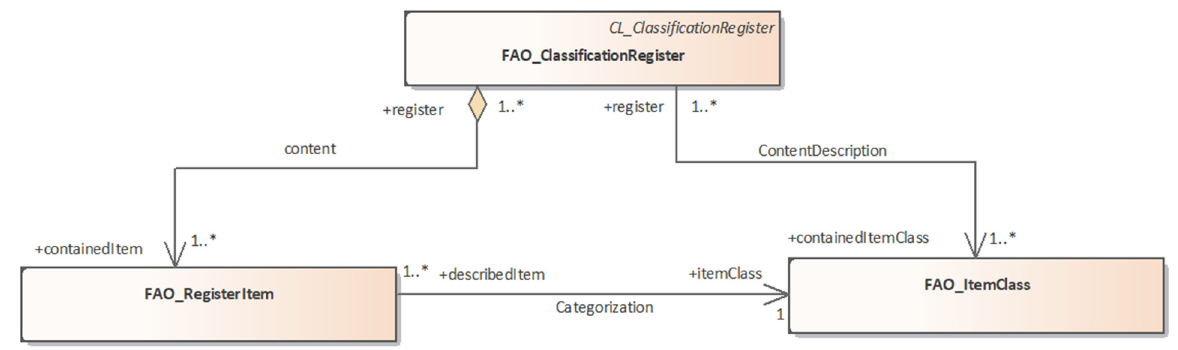
Figure 2. Structure of the land cover legend registry. Reprinted/adapted with permission from Ref. [28]. 2021, FAO, UoS and STIIMA-CNR. * Multiplicity (https://khalilstemmler.com/articles/uml-cheatsheet/, accessed on 15 June 2022): a classification register can have 1 or more register/Register- Item/ItemClass.